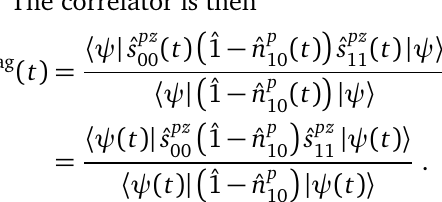
and , ˆ s pz 11 00